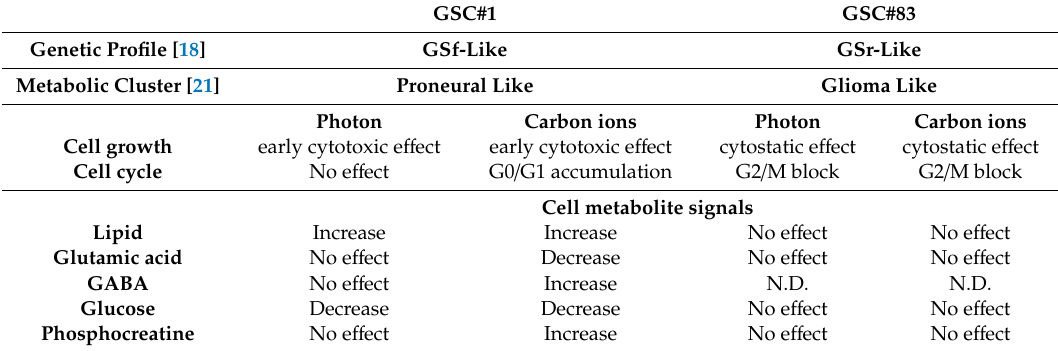
Table 1. GSC lines metabolic and biological response to photon and carbon ion irradiation at 20